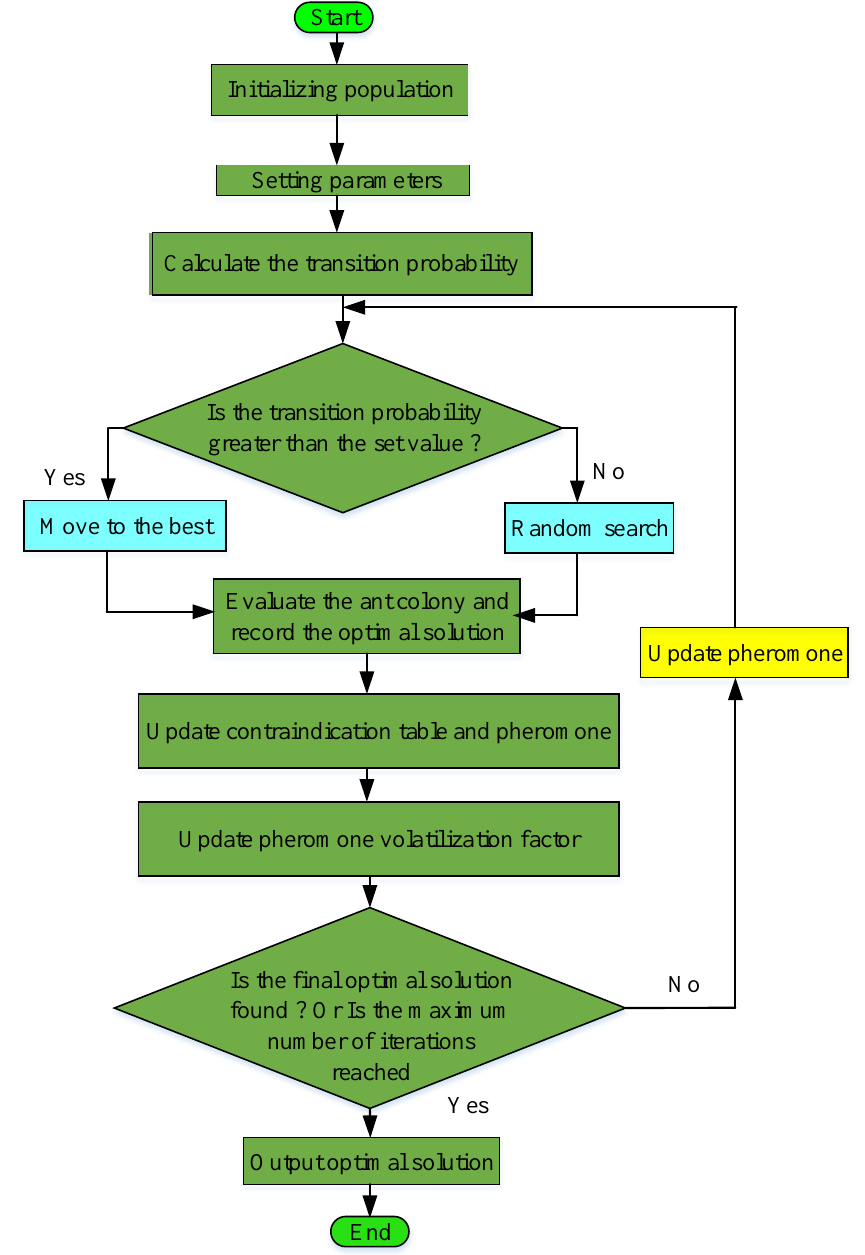
Figure 7. Improved flow chart of ant colony optimization (ACO).